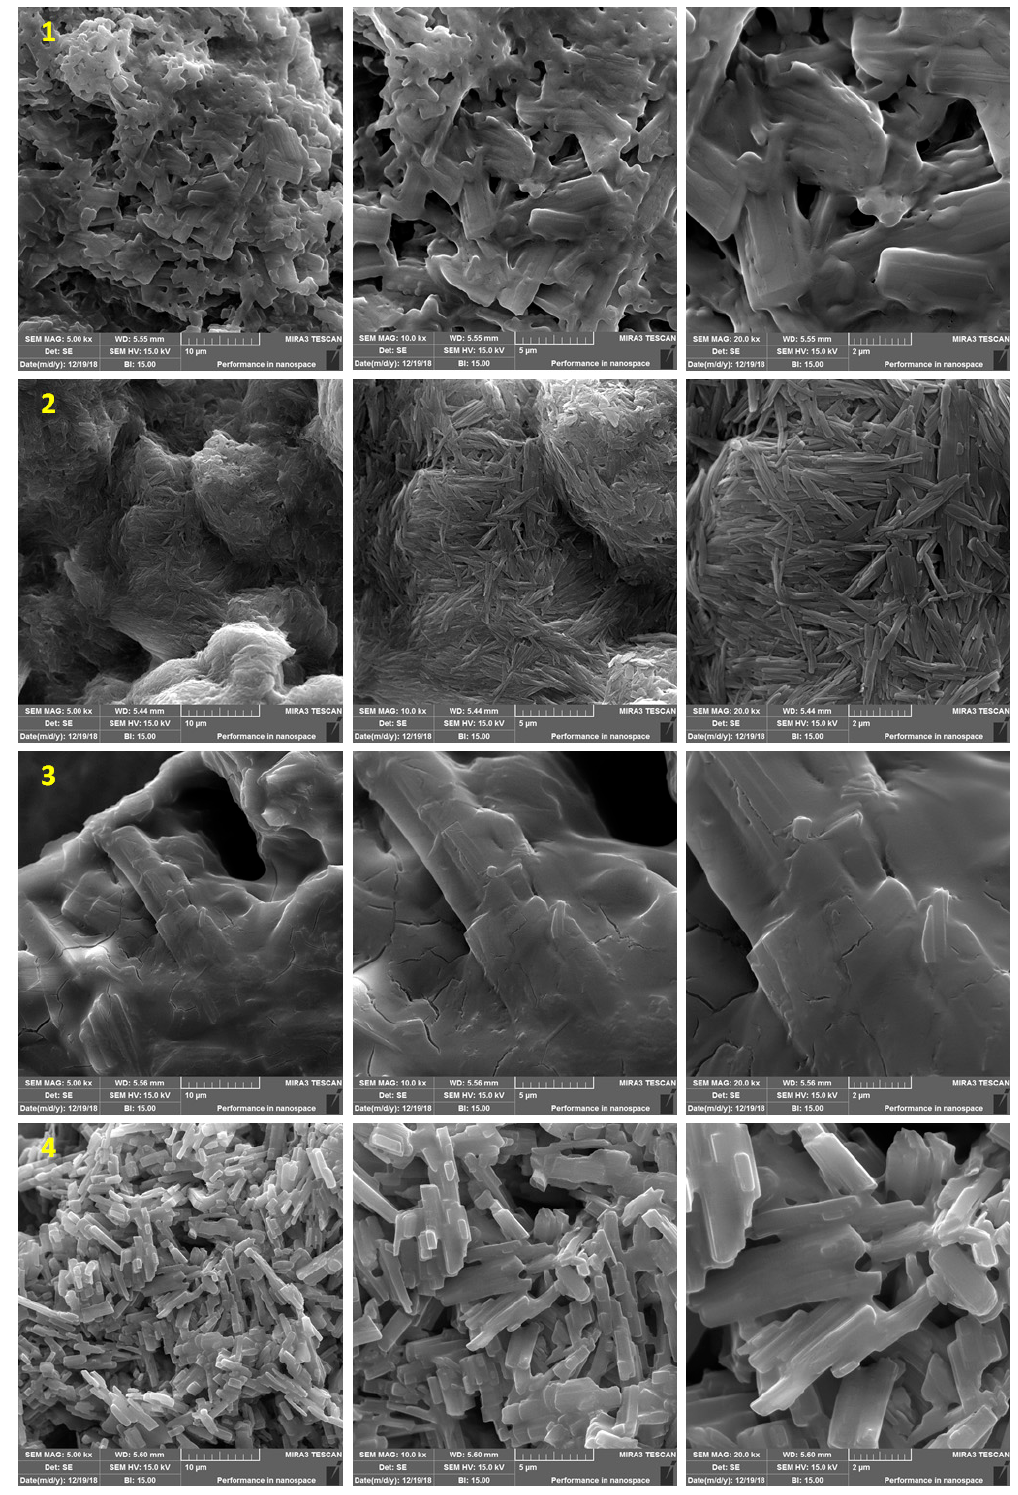
Figure 3. Field emission scanning electron microscopy (FESEM) images of 1 – 4 .